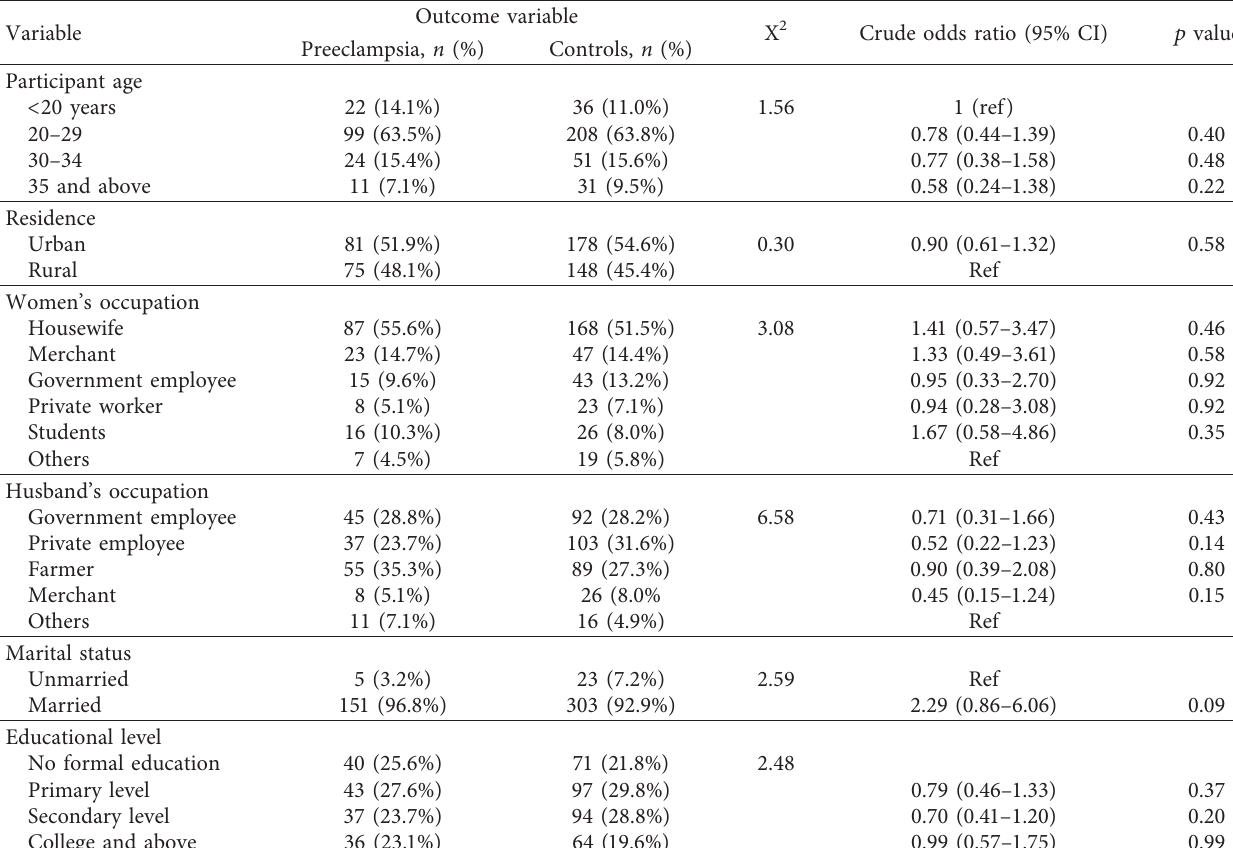
Table 1: Sociodemographic characteristics of women enrolled for a case-control study conducted among singleton pregnant women attending perinatal care in Omo district hospitals, southern Ethiopia. Individual and family-related characteristics of